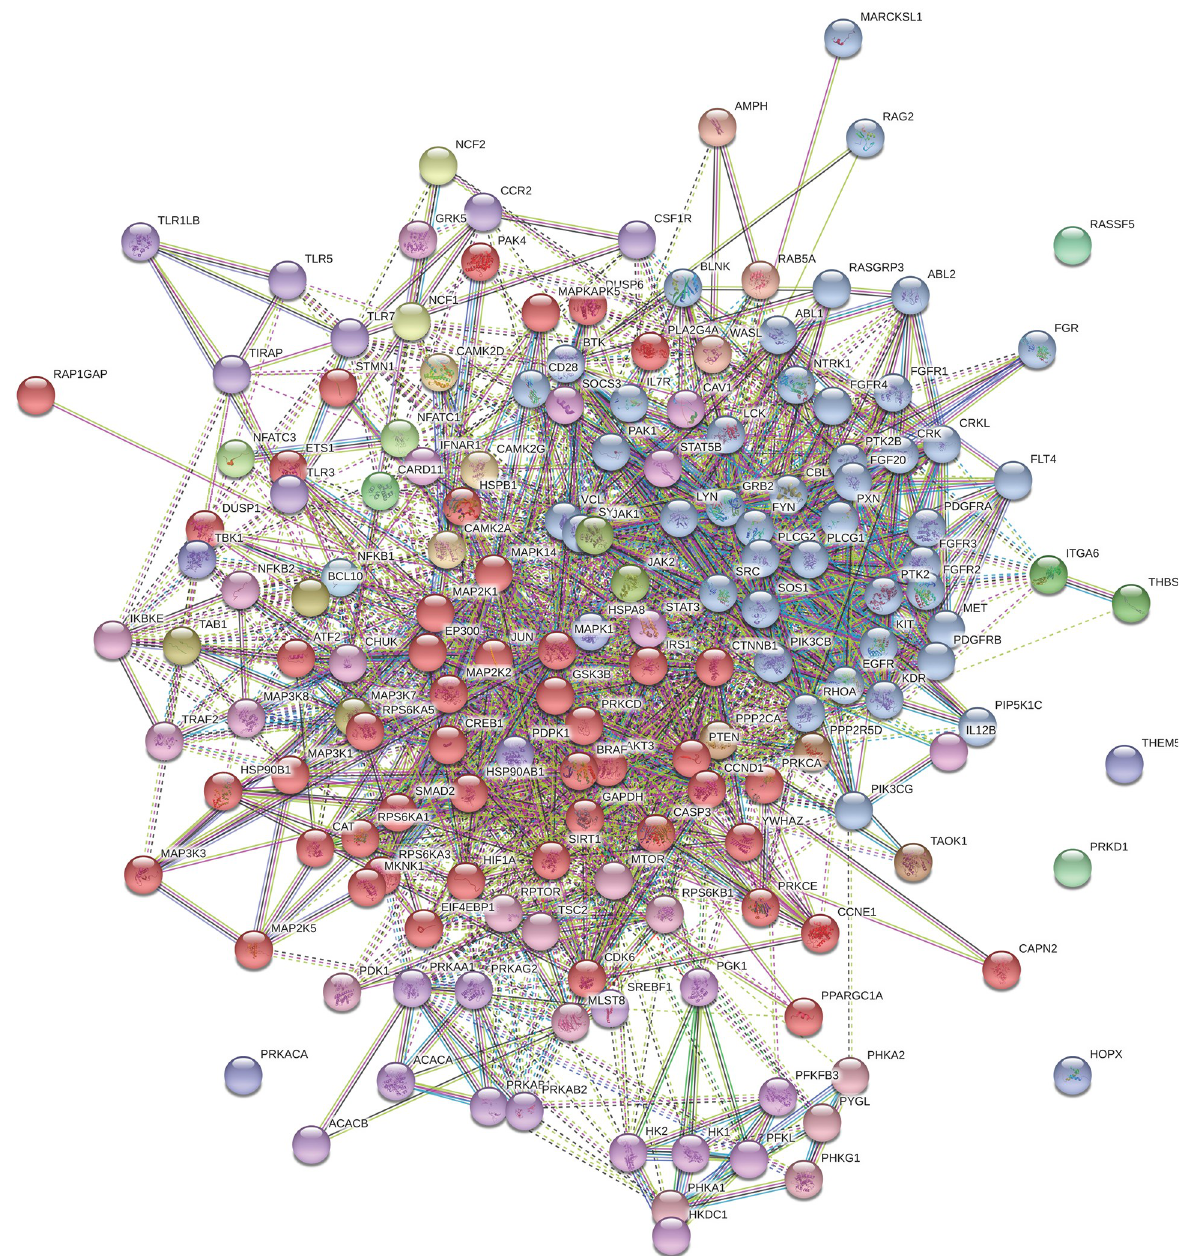
Fig 1. Markov Cluster of significant proteins in the ileum. Ileal protein-protein interactions in ileum were analyzed using the Markov Cluster (MCL) algorithm ( P � 0.05) in the STRING database.